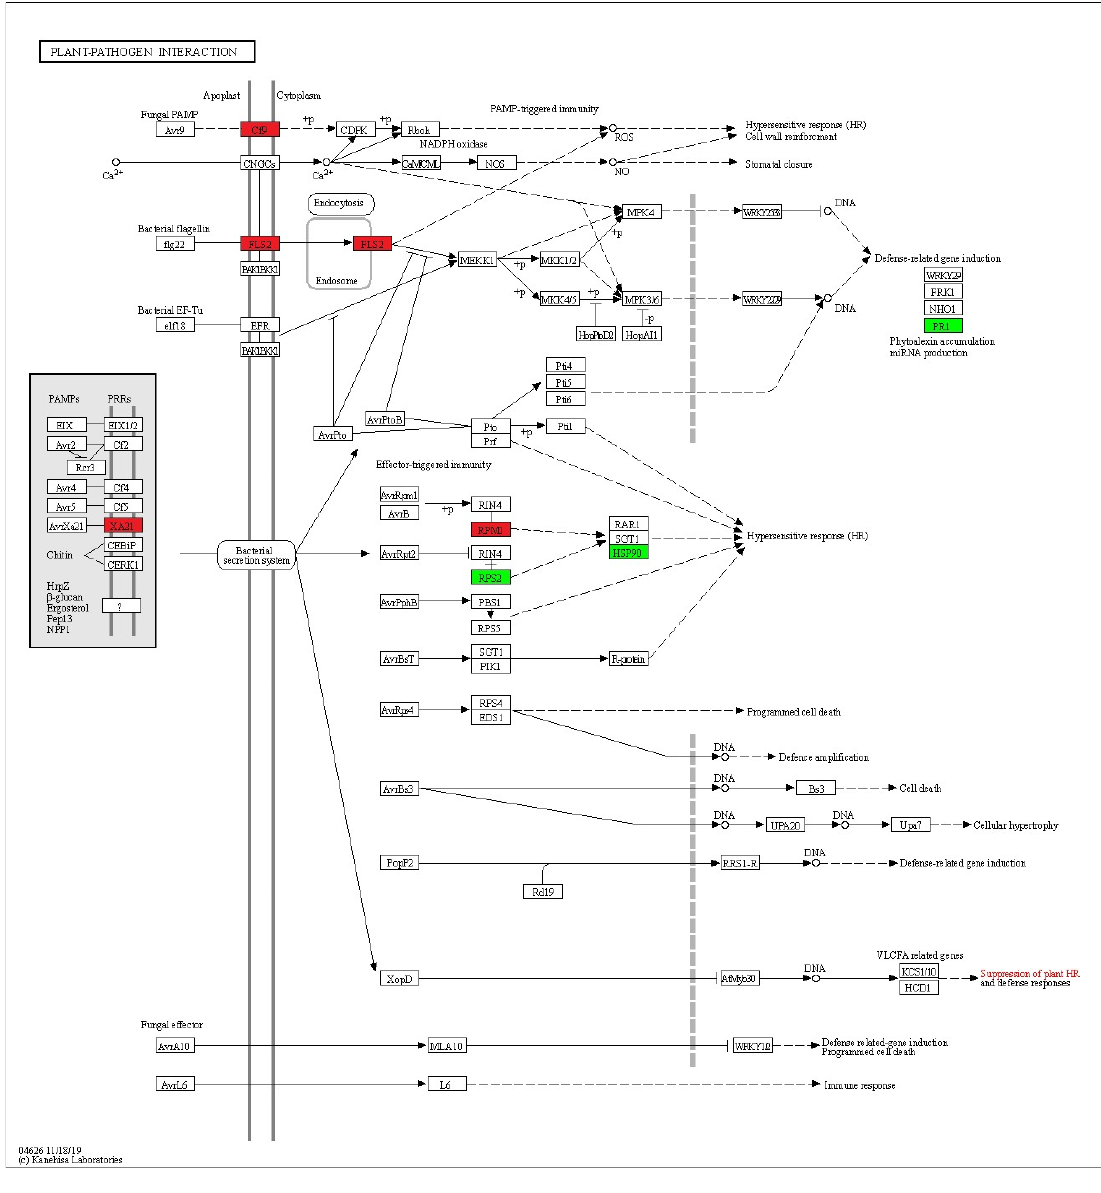
Figure 4. Transcripts related to plant–pathogen interactions in C Las-infected Persian lime leaves. The green boxes indicate upregulated genes, and red boxes indicate downregulated genes. The annotation was calculated with KEGG Blast